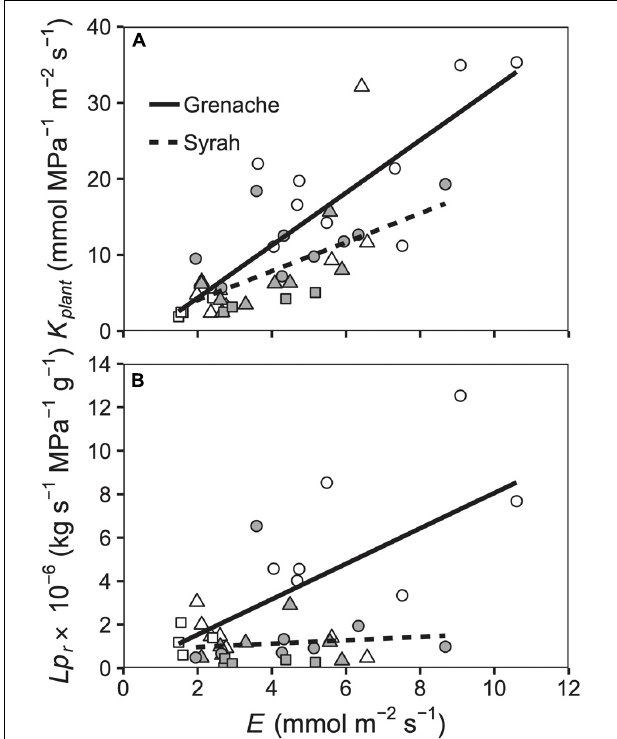
FIGURE 4 | Relationship between E and K plant (A) and Lp r (B) for well-watered (circles), water deficit (triangles), and ABA treated vines (squares) for the cultivars Grenache (open symbols) and Syrah (filled symbols). (A) K plant was positively correlated to E for both Grenache [ K plant = 3.5 ± 0.5 × E – 2.6 ± 2.7; r = 0.84] and Syrah [ K plant = 1.9 ± 0.5 × E + 0.3 ± 2.4; r = 0.63]. The slopes were not significantly different. (B) Lpr had a significant different ( P = 0.027) relationship to E in the cultivar Grenache [ Lp r = 0.8 ± 0.2 × E – 0.1 ± 1.1; r = 0.69] compared to the cultivar Syrah [ Lp r = 0.1 ± 0.2 × E